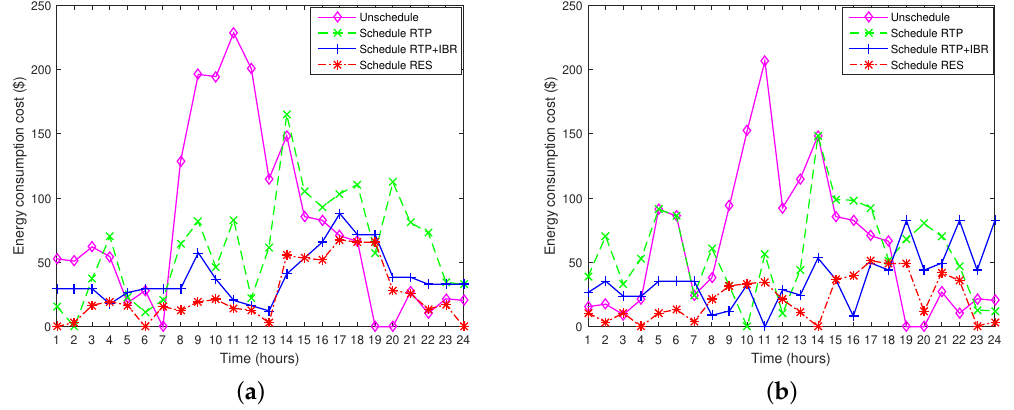
Figure 9. Unscheduled and scheduled cost profiles against various cases; RTP, RTP+IBR and RES. ( a ) without control parameter; ( b ) with control